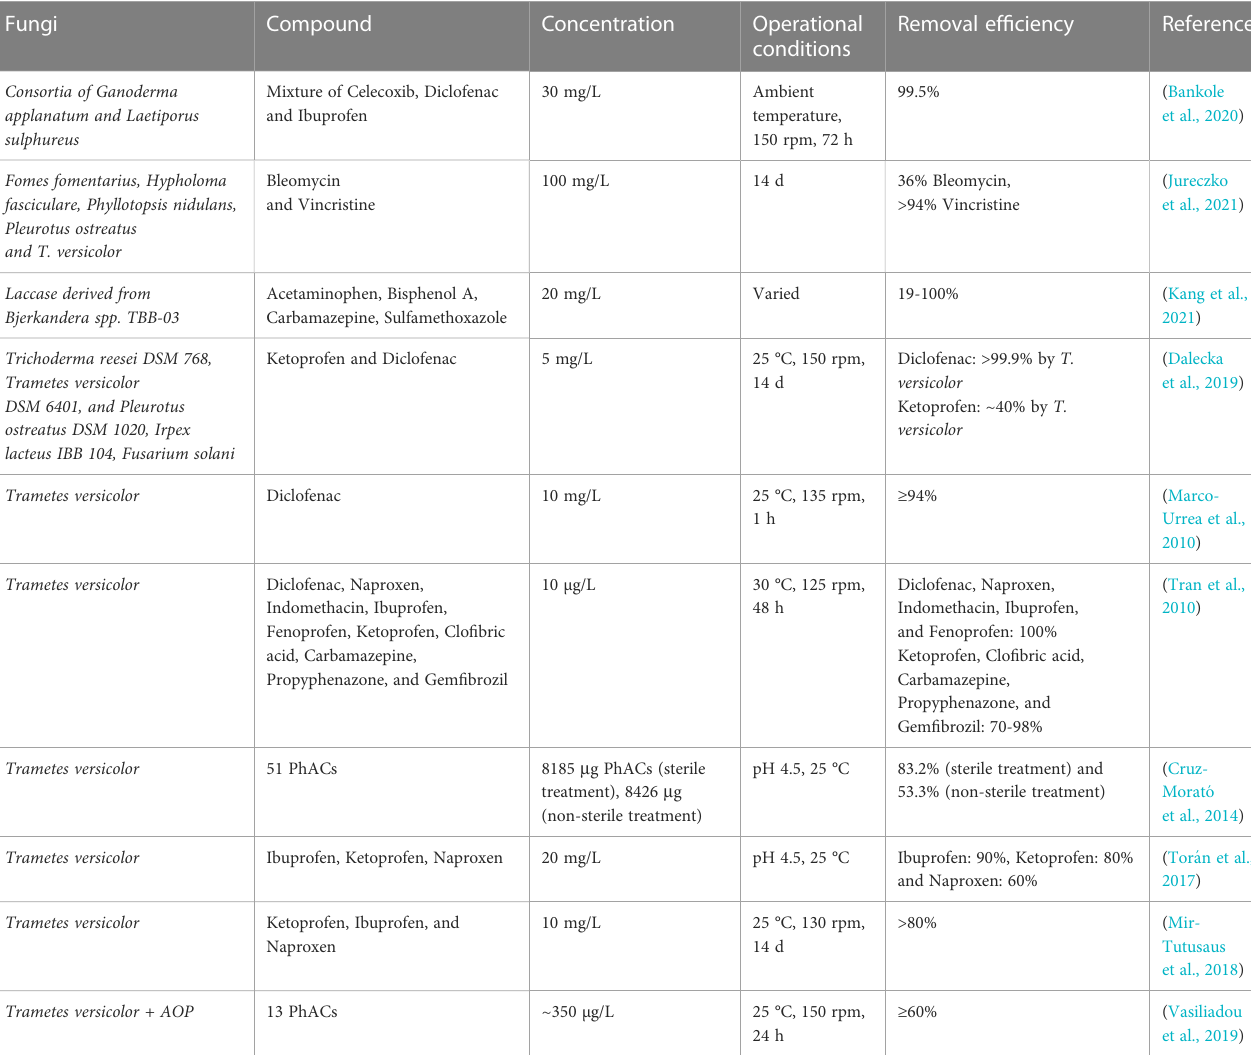
TABLE 3 Examples of application of fungi for the biodegradation of pharmaceuticals and personal care